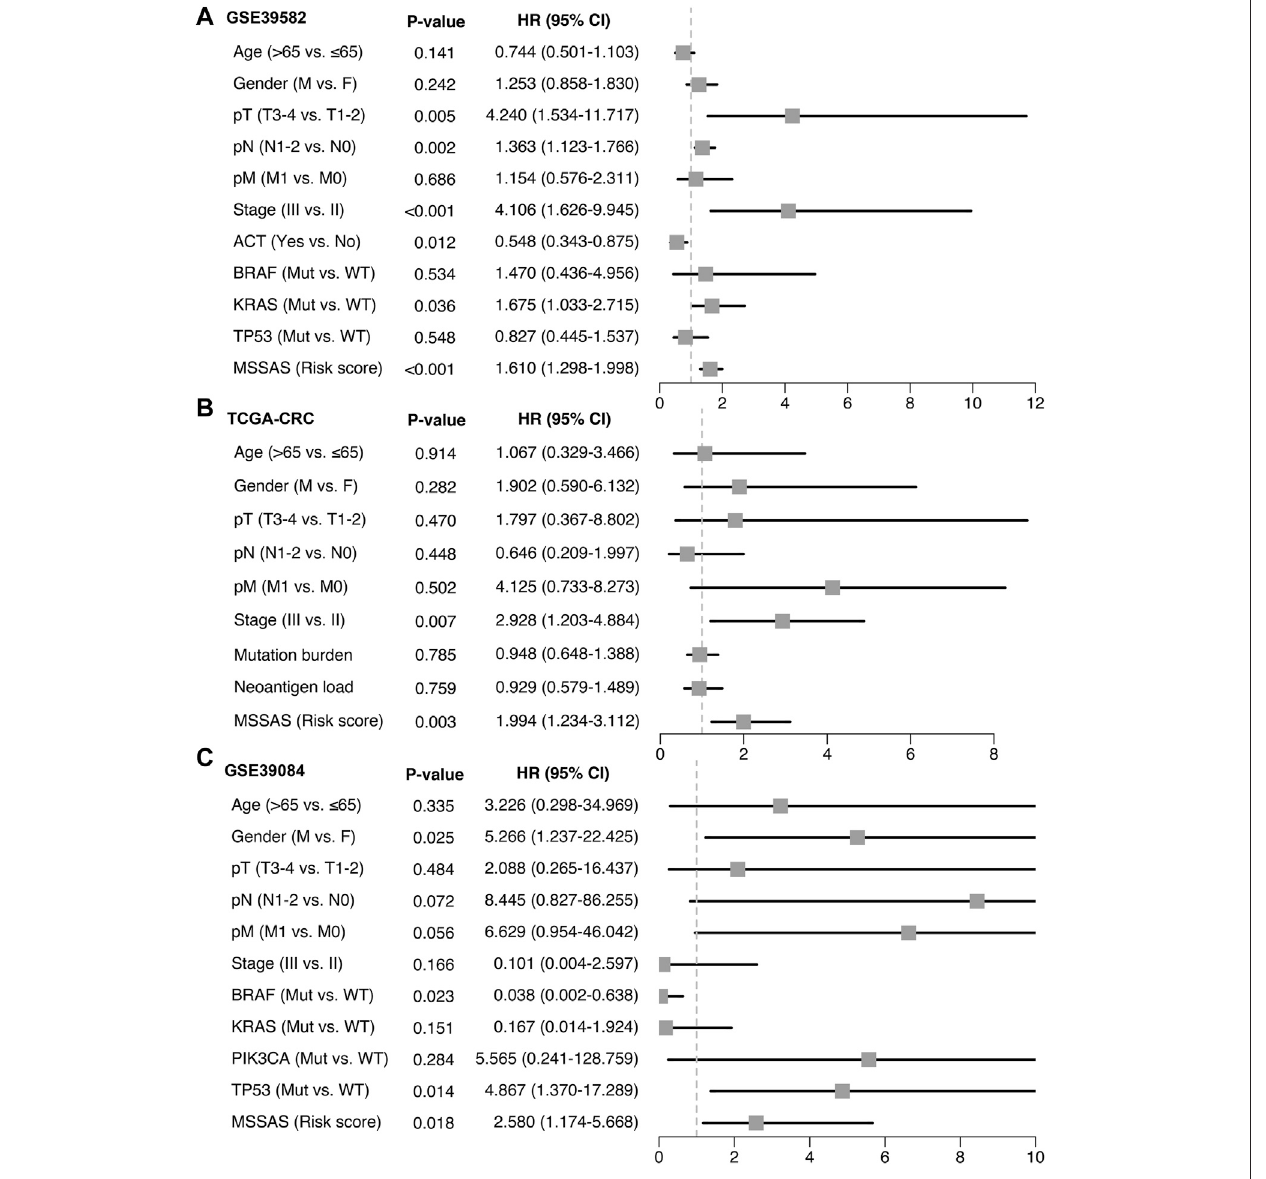
Frontiers in Cell and Developmental Biology |